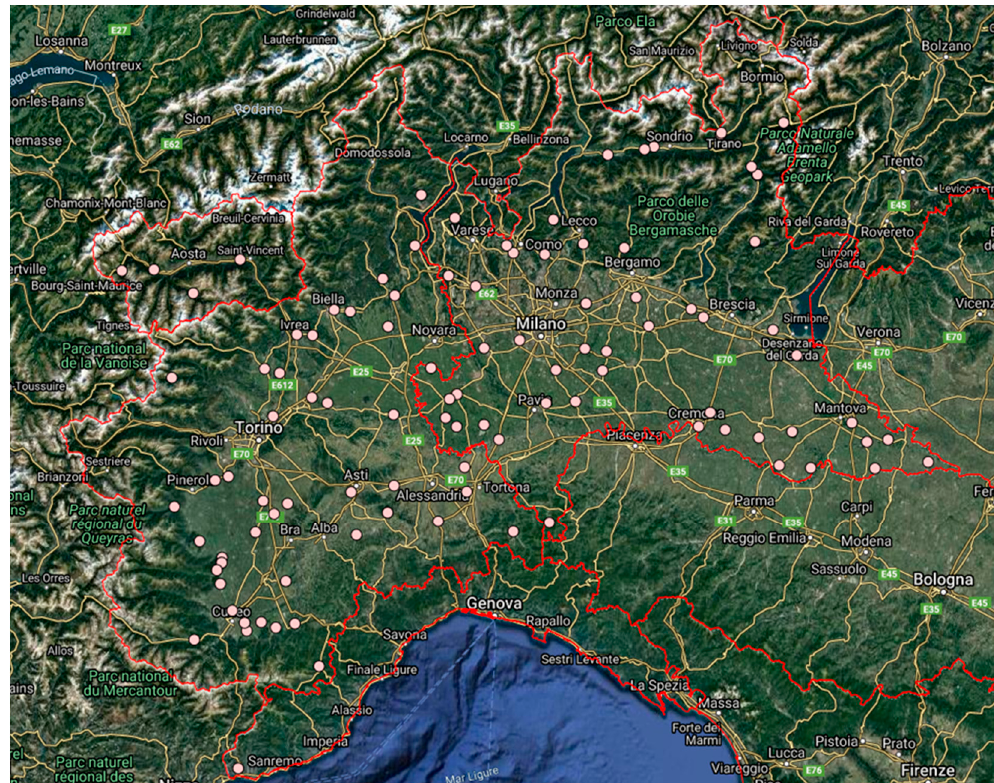
Figure 3. Map with the location of plants for electrical production from solid biomass in north-west Italy (Source: Gestore Servizi Energetici (GSE) Atlaimpianti [57]).